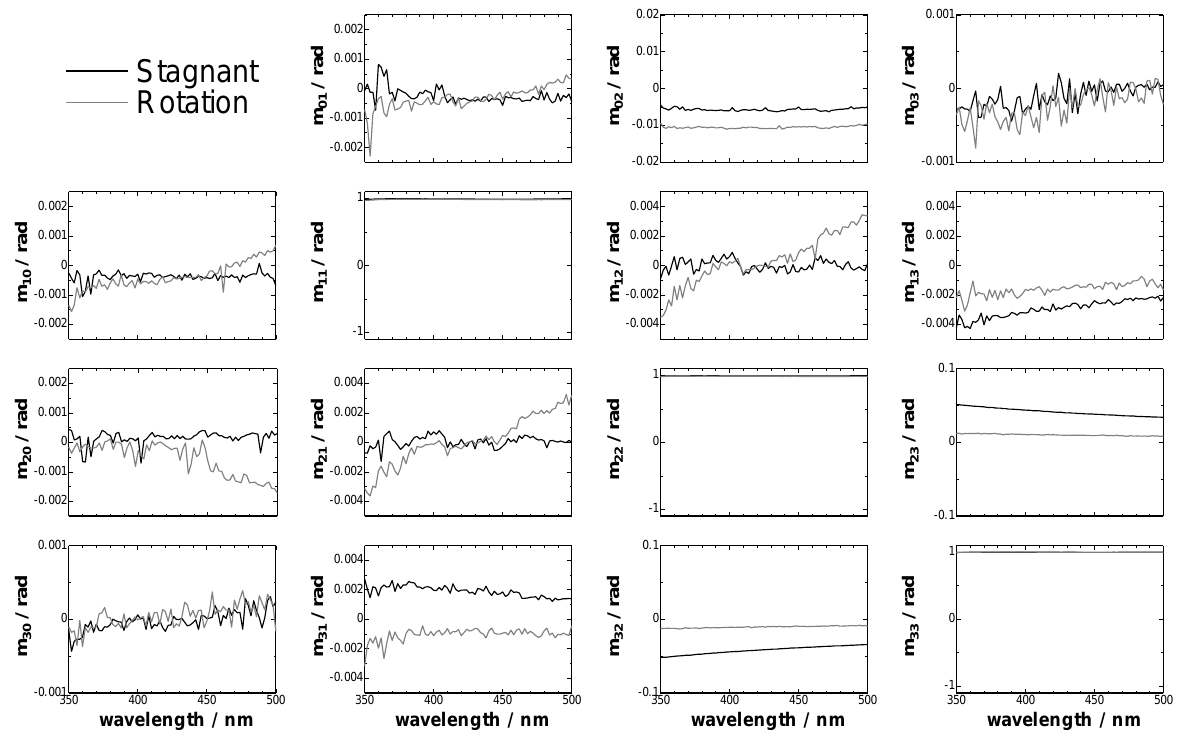
Figure 1. Detail of the observed normalized Mueller matrices of CLM cell.